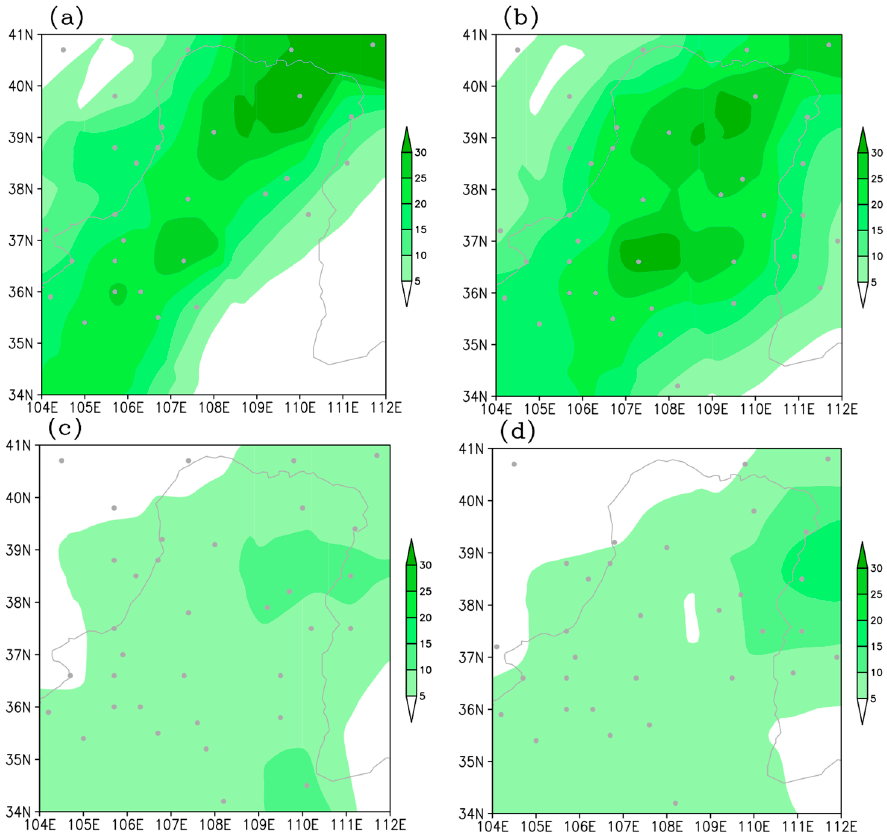
Figure 11. Composite of the total rainfall amount (mm/day) over the YRLV for the events in CE-1 ( a ), CE-2 ( b ), CN-1 ( c ), and CN-2 ( d ); the gray dots denote the 95% confidence level.